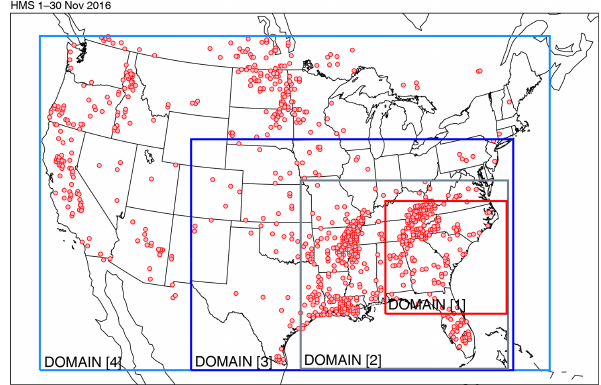
Figure 3. Geographical coverage of case study domains. Red dots indicate HMS fire detections during November 2016. The four la- beled domains indicate spatial coverage of fire source inputs for the inverse system used in the sensitivity